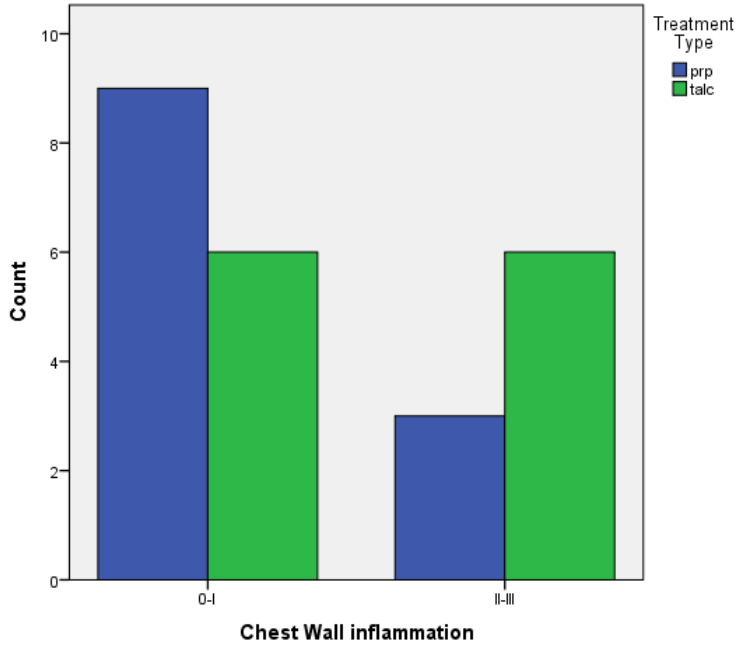
Figure 6. Parietal pleura inflammation of PRP vs. talc.